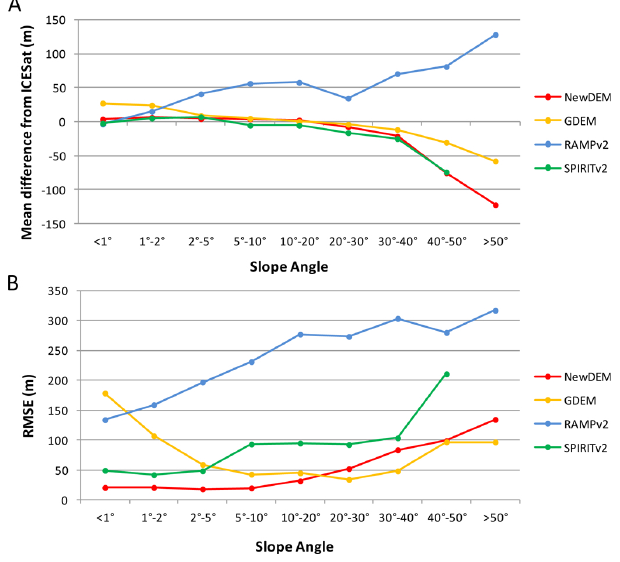
Figure 8. Mean di ff erence of each DEM from ICESat categorized by slope (A) ; RMS errors categorized by slope (B) .